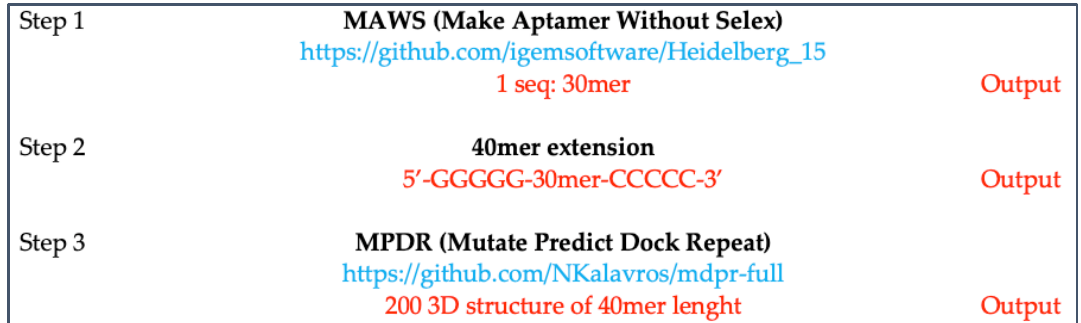
Figure 11. Schematic representation of the workflow.